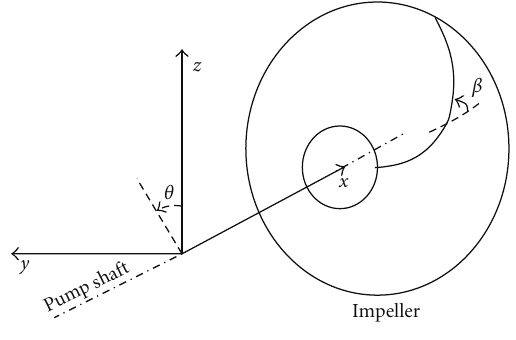
Figure 1: Cylindrical coordinate system.